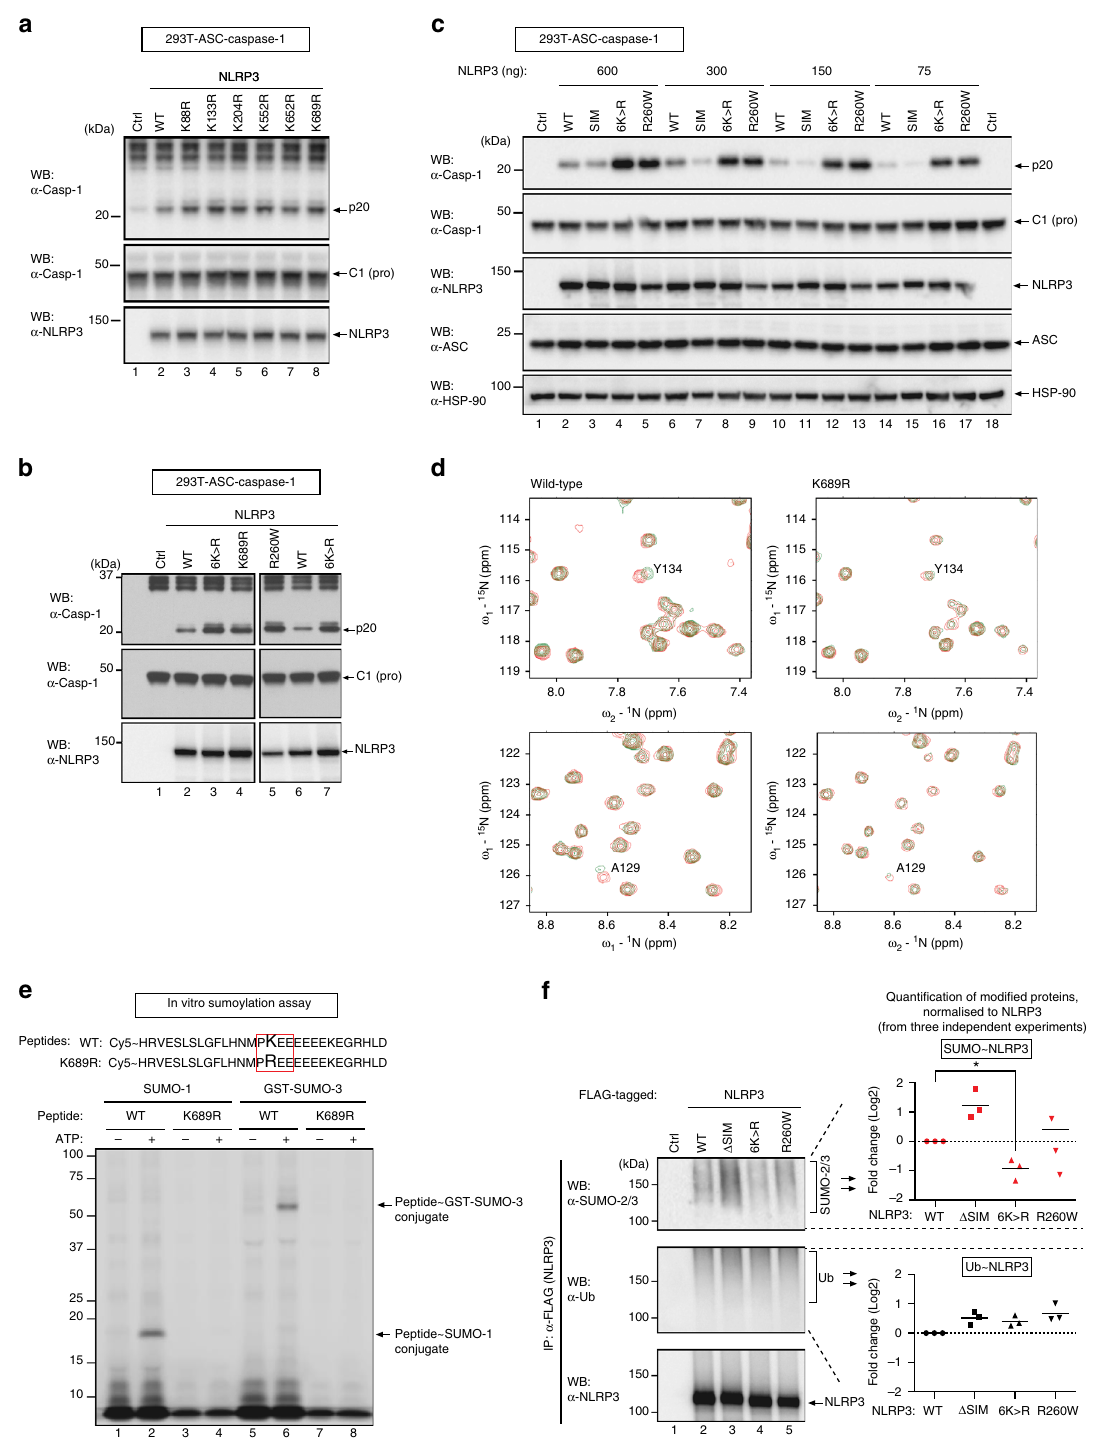
Fig. 5 Mutation of SUMO acceptor lysines results in hyperactive NLRP3. a – c Immunoblot analysis of in fl ammasome components (caspase-1, ASC and NLRP3) in cell lysates of HEK239T cells, stably expressing ASC and caspase-1, transfected with the indicated proteins. Caspase-1 maturation (p20 band) was evaluated by western blot. d NMR analysis of the interaction between UBC9 and WT and K689R mutant NLRP3 peptides. Overlays of the expanded regions of 1 H- 15 N HSQC spectra of free UBC9 (red) and UBC9 in complex with the peptide at 8:1 molar ratio (green). Only peaks with signi fi cant chemical shift perturbation are labelled with their assignments. e In vitro sumoylation assays of WT and mutant peptides using SUMO-1 or GST-fusion SUMO-3. f HEK293T cells were transfected with plasmids expressing the indicated proteins and FLAG-NLRP3 immunoprecipitates were evaluated for sumoylation and ubiquitylation. The modi fi cations were quanti fi ed using Image Lab Software (Bio-Rad) and normalised to total immunoprecipitated NLRP3. The data of three independent experiments are presented as log2-transformed fold changes of the mutants compared to WT NLRP3. Line represents the mean. * P < 0.05; two-tailed Student ’ s t -test comparing each individual mutant to WT